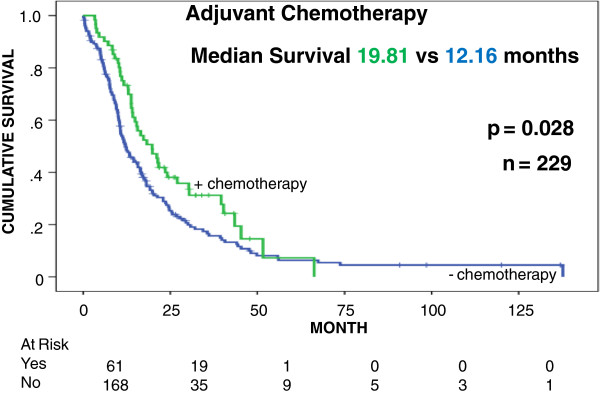
STAG2 expression and response to adjuvant therapy. Cumulative survival (y-axis) plotted versus time (x-axis) is compared for the 229 STAG2-deficient patients who received (n = 61) or did not receive (n = 168) adjuvant chemotherapy. Mo, months.